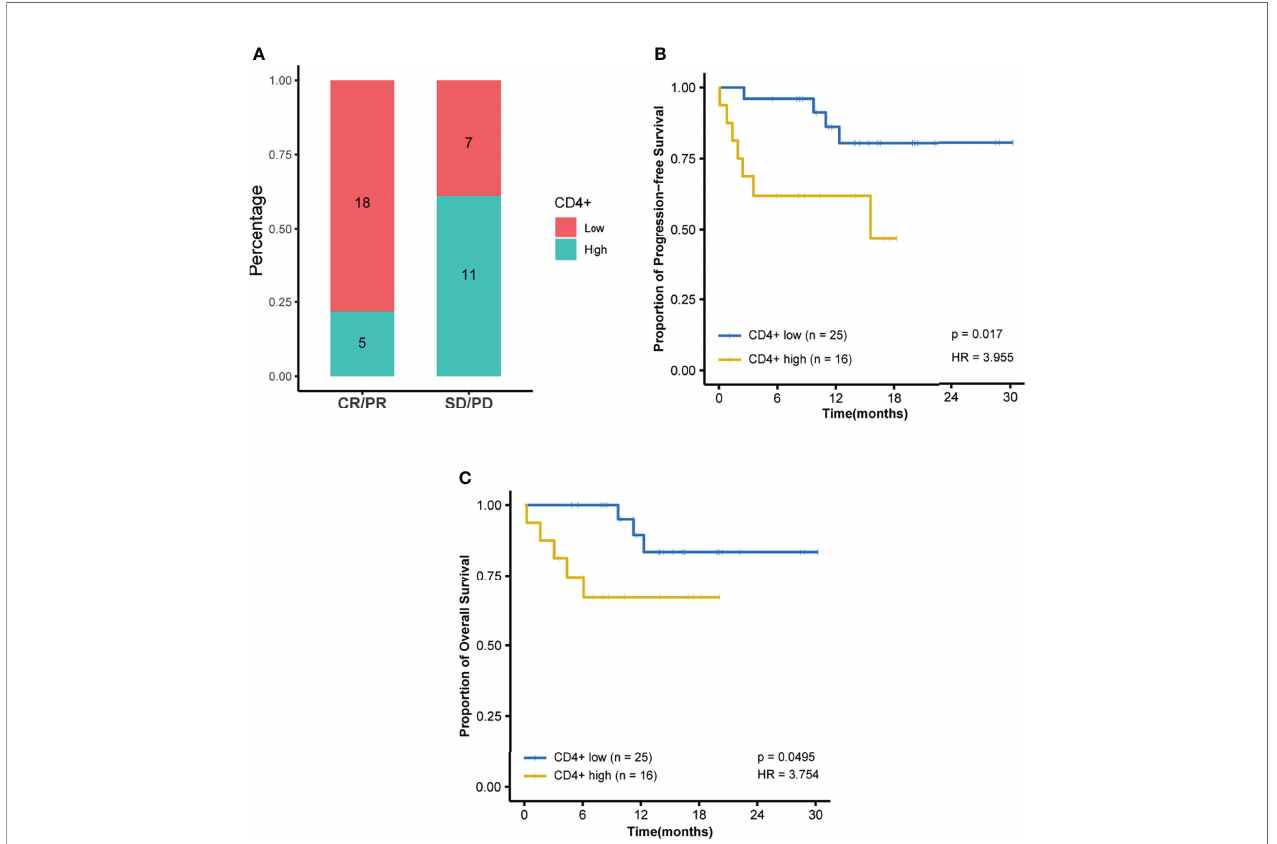
FIGURE 5 | Frequency of CD4+ T cell is predictive of response and survival outcome. Optimal cutoff point was calculated by receiver operating characteristic (ROC) curve analysis to dichotomize patients into high and low groups. (A) Frequency of CD4+ T-cell distribution is visualized by a histogram between treatment response groups (CR, complete response; PR, partial response; SD, stable disease; PD, progressive disease). (B) Kaplan – Meier survival curves for progression-free survival and (C) Kaplan – Meier survival curves for overall